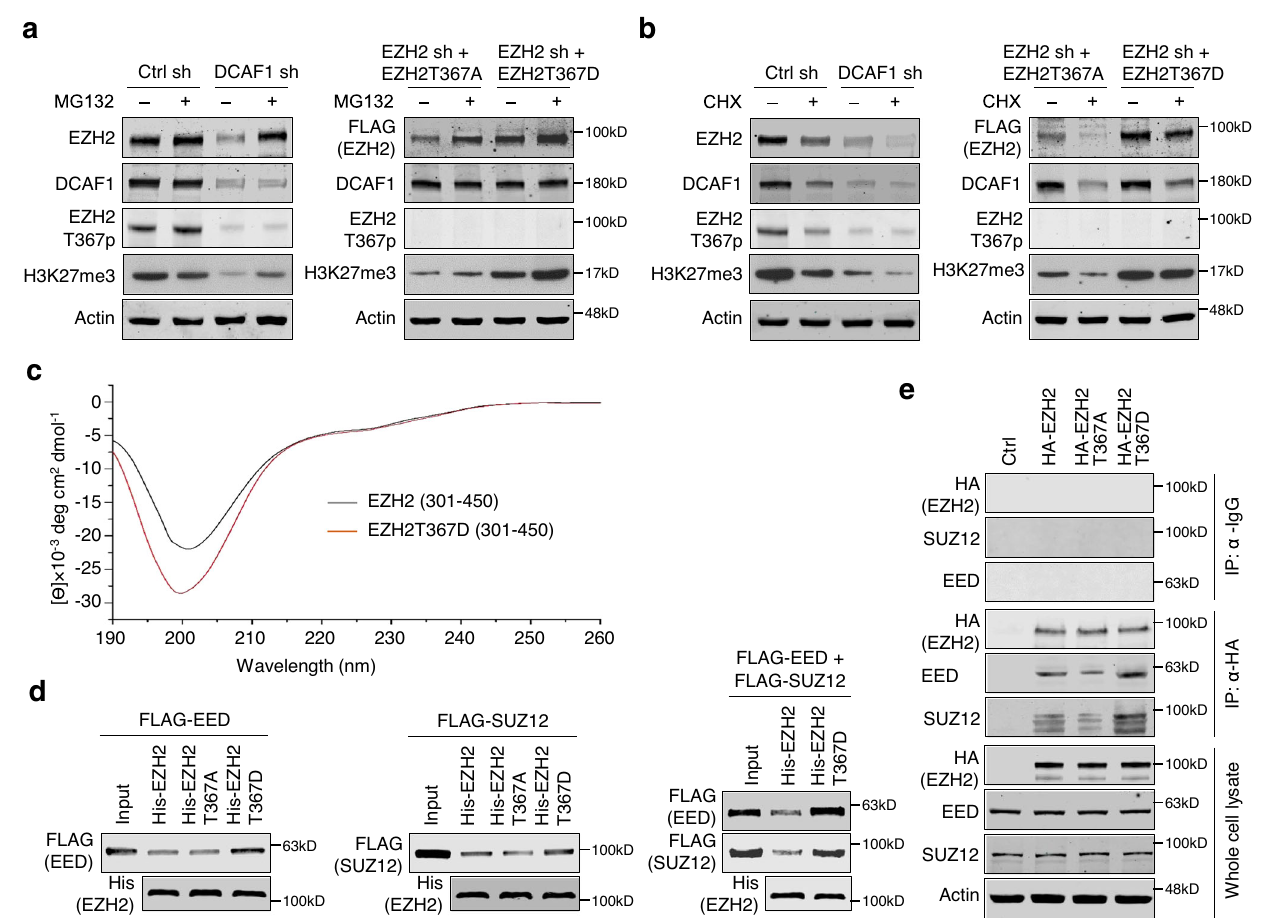
Fig. 3 | Regulation of EZH2 degradation by DCAF1-mediated phosphorylation. a Control (Ctrl) and DCAF1-depleted SW620 colon cancer cells were treated with MG132 (10 µ M) for 12h, and cell lysates were collected and immunoblotted with antibodies against EZH2, DCAF1, EZH2T367p, and H3K27me3 (left panel). EZH2- depleted SW620 cells were infected with lentiviruses expressing 3×FLAG- EZH2T367A phospho-blocking mutant and T367D phospho-mimicking mutant followedbytreatmentwithMG132(10 µ M)for12handanalyzed(rightpanel).Actin was used as a loading control. Data are representative of three independent experiments. b SW620 cells used in (A) were treated with CHX (50 µ g/ml) for 6h, and cell lysates were prepared and analyzed by Western blotting. Data are repre- sentative of three independent experiments. c Circular dichroism spectra of wild type EZH2 (300-450) and EZH2T367D (300-450) were recorded at protein con- centrations of 5 µ M in spectrum buffer (20mM K 2 HPO 4 /KH 2 PO 4 , pH 7.4, 25mM